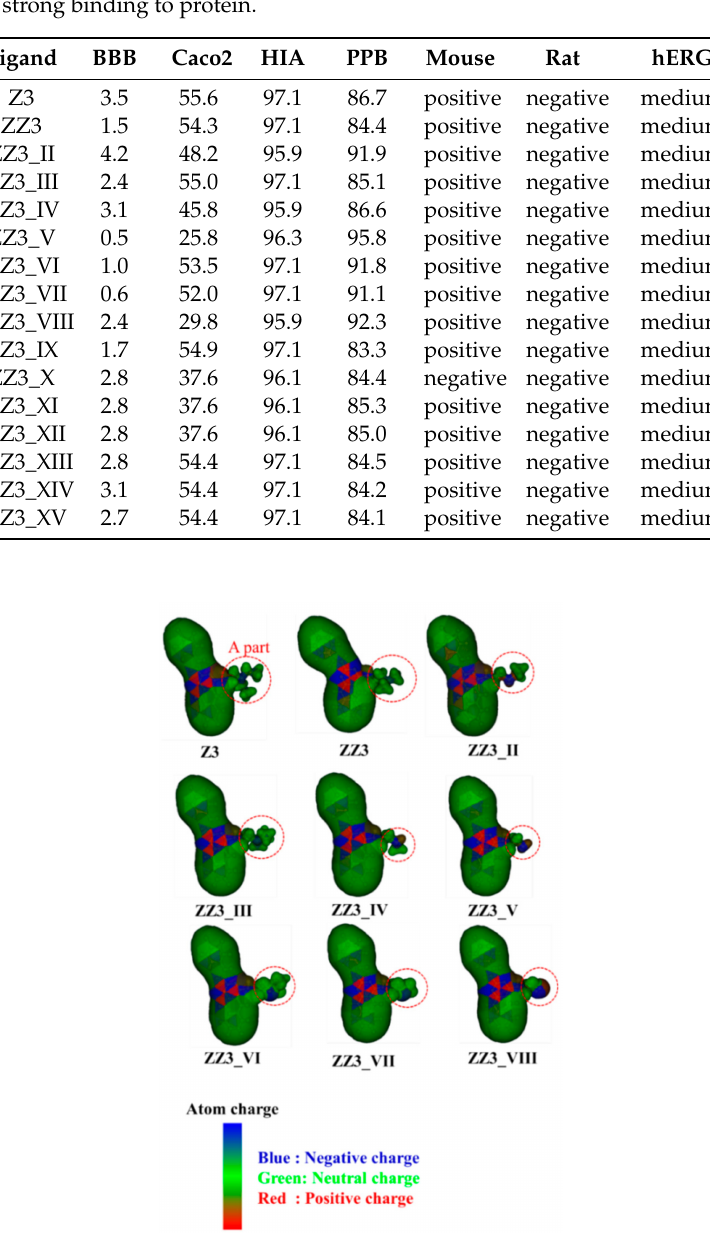
Figure 3. Charge distributions for Z3 and ZZ3 and its derivatives with replacing the A-part of ZZ3. The distributions are analyzed by RESP method of